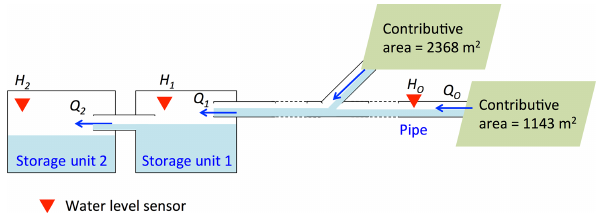
Figure 3. Location of the water level sensors in the storm-water management network.